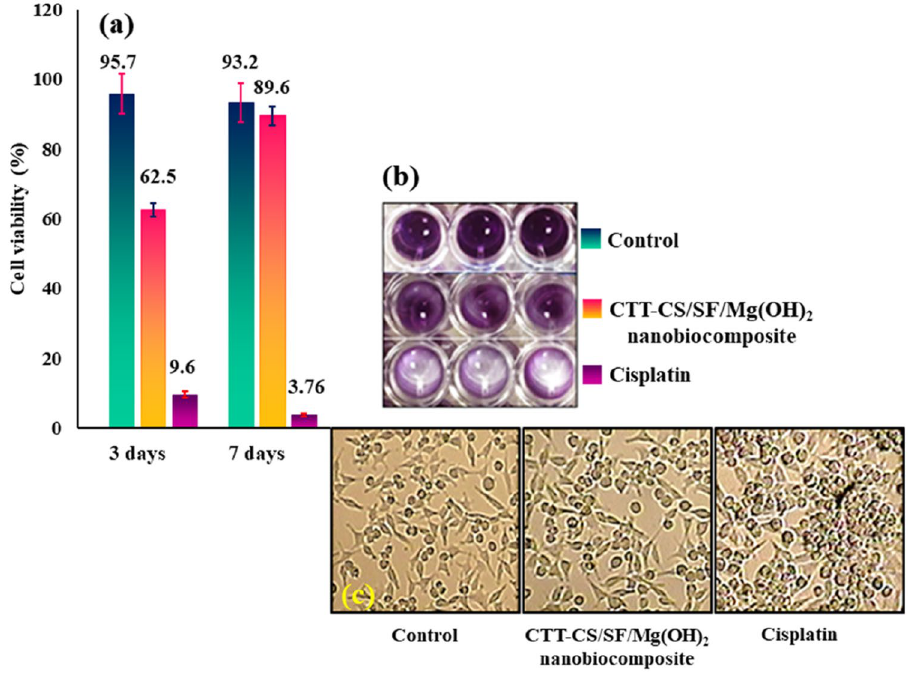
Figure 7. ( a ) Cell viability histogram of untreated Hu02 cells as control, CTT-CS/SF/Mg(OH) 2 nanobiocomposite scaffold and cisplatin treatments at 3 days and 7 days, ( b ) image of microplate well from MTT assay on Hu02 cell line, ( c ) inverted microscope images of untreated cells as control, CTT-CS/SF/ Mg(OH)